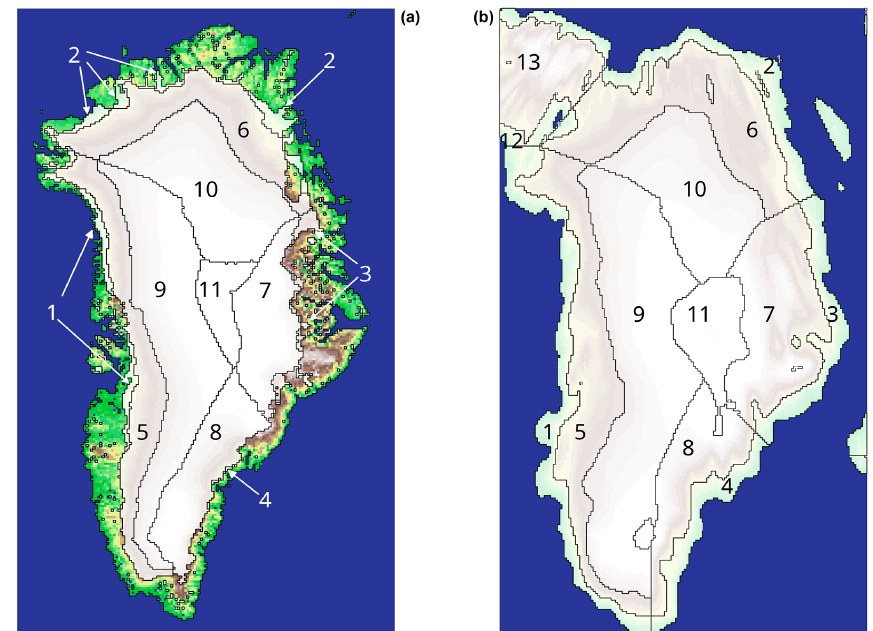
Figure 5. Greenland is split into 11 regions based on elevation, geographic, and climatic similarity for the PD (a) and the LGM (b) . There are four different sections with SW–W, N, E, SE, and the area around Ellesmere island for the LGM. Each section is split into three elevation bands ranging from 0–1000–2000–3000m. During the present day there are three regions in the west and north from 0–1000–2000–3000m (1, 5, and 9; 2, 6, and 10). The southeast and east regions are precipitation driven, and the change in SMB with altitude is less developed; therefore 1000–3000m is joined to one region (4, 8; 3, 7). There is one additional region in the center which is at elevations above 3000m (11). Ice-covered areas are in white with slight elevation shading in the background. The ice-free area is based on elevation coloring with green as the lowest and brownish the